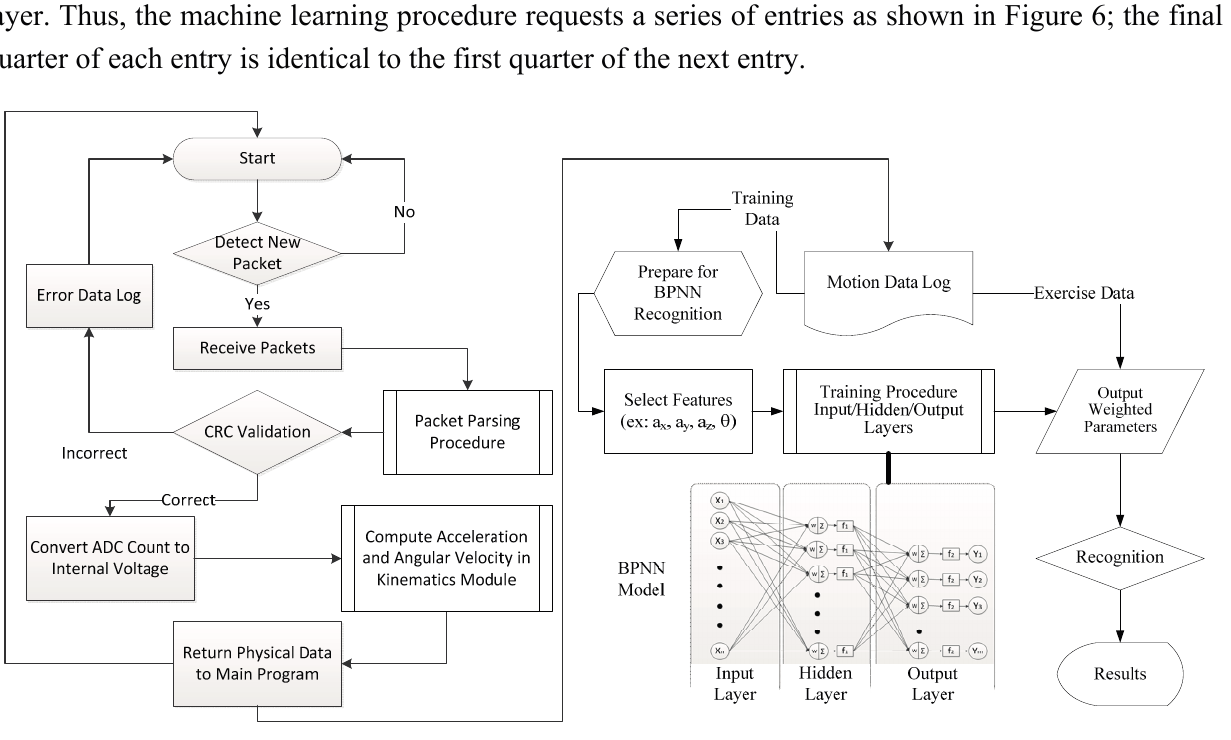
Figure 5. Flow chart of the WSN-ISN-based measurement and recognition procedure with BPNN.